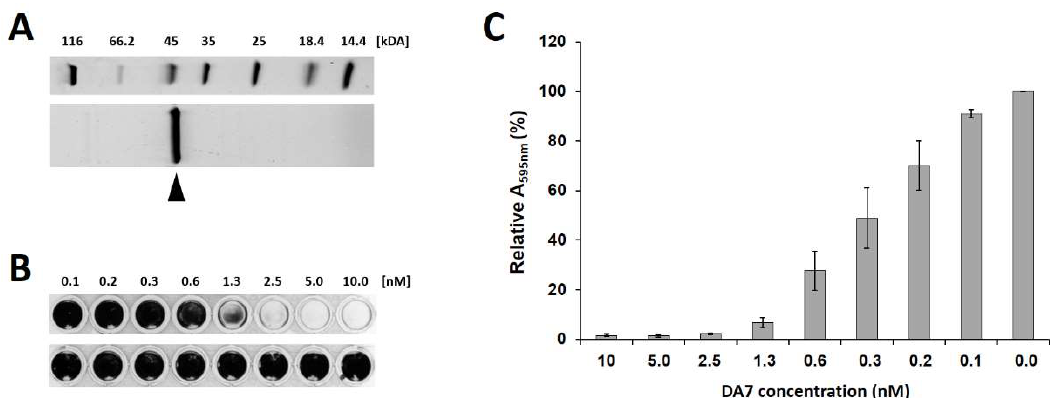
Figure 3. Purification and anti-biofilm activity of the polysaccharide depolymerase DA7. ( A ) Sodium dodecyl sulfate polyacrylamide gel electrophoresis (SDS-PAGE) of purified DA7 protein. The band of interest (expected molecular weight: 42.1 kDa) is marked by an arrow. ( B ) Static S. aureus SA113 biofilms were grown at 30 ◦ C for 24 h, treated with increasing concentrations of DA7 ( top ) or buffer as a control ( bottom ) for 30 min at 30 ◦ C, and stained with crystal violet (CV). ( C ) Relative A 595nm values measured after dissolving the CV stain on residual biofilms in 96% ethanol after DA7 treatment as shown in panel B. Values are normalized to the control, and error bars represent standard errors of the mean from three independent experiments.